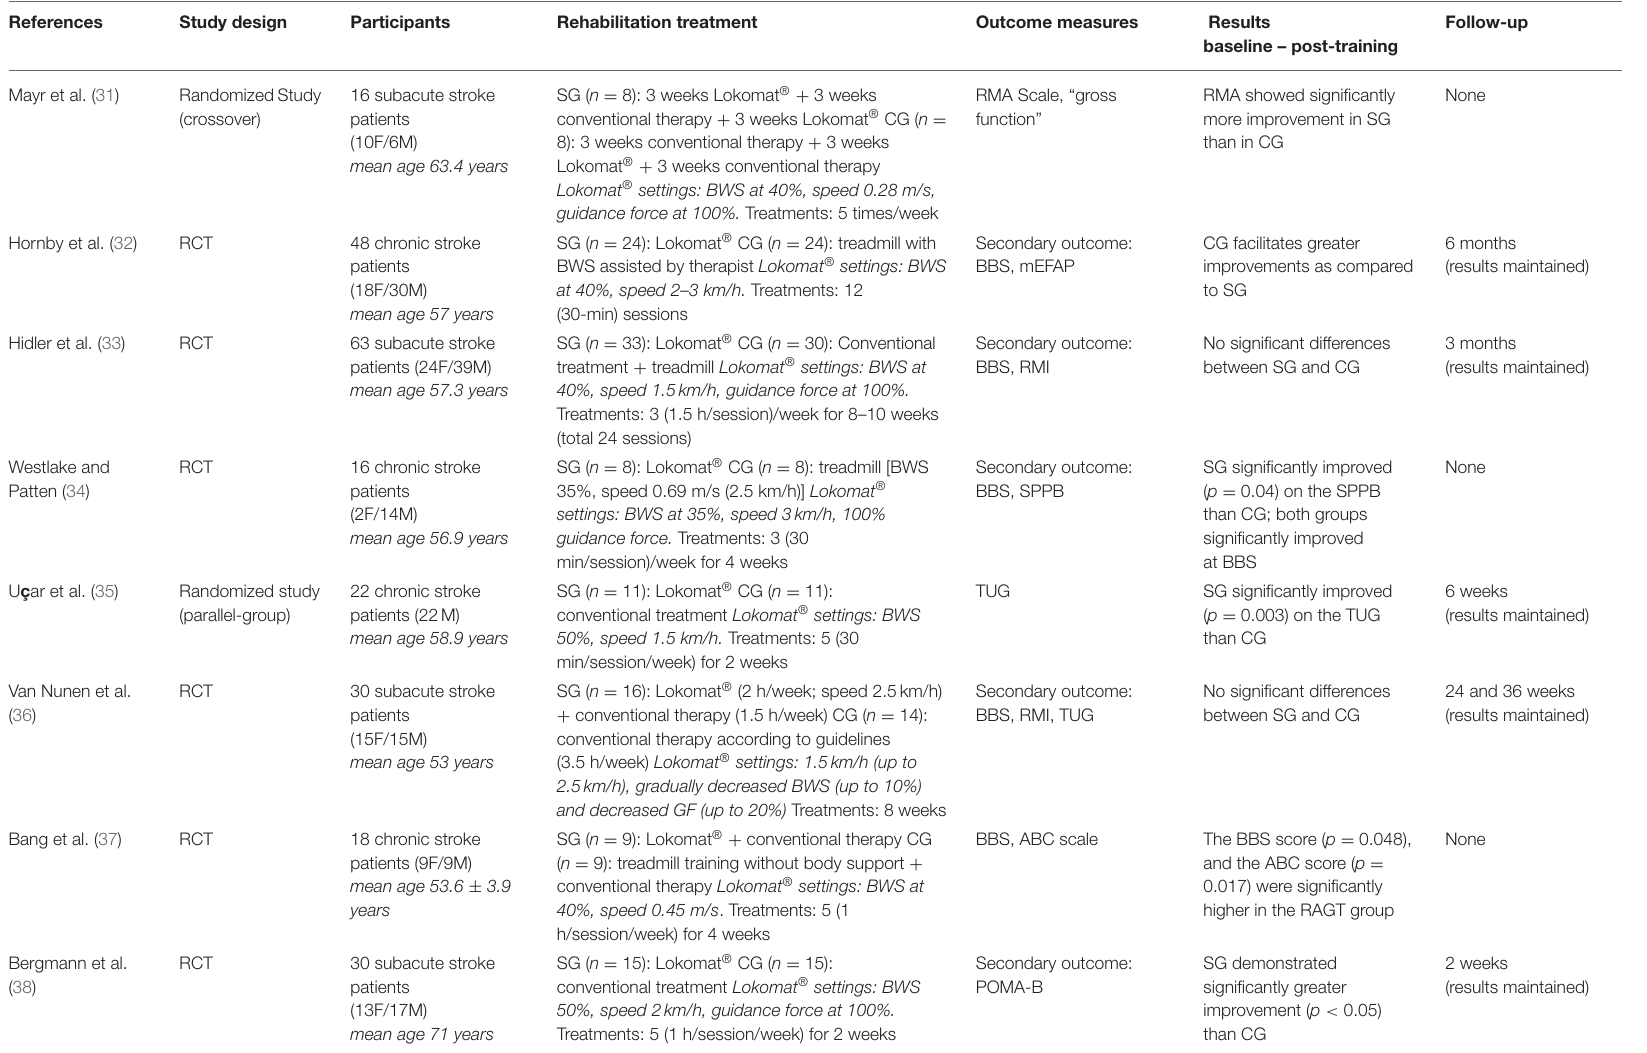
TABLE 2 | Main features of the included